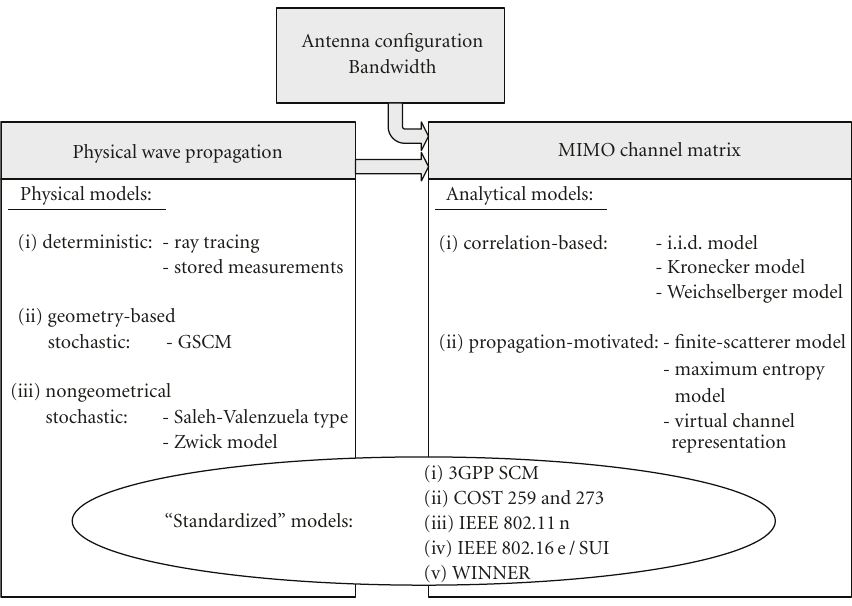
Figure 2: Classification of MIMO channel and propagation models according to [19, Chapter